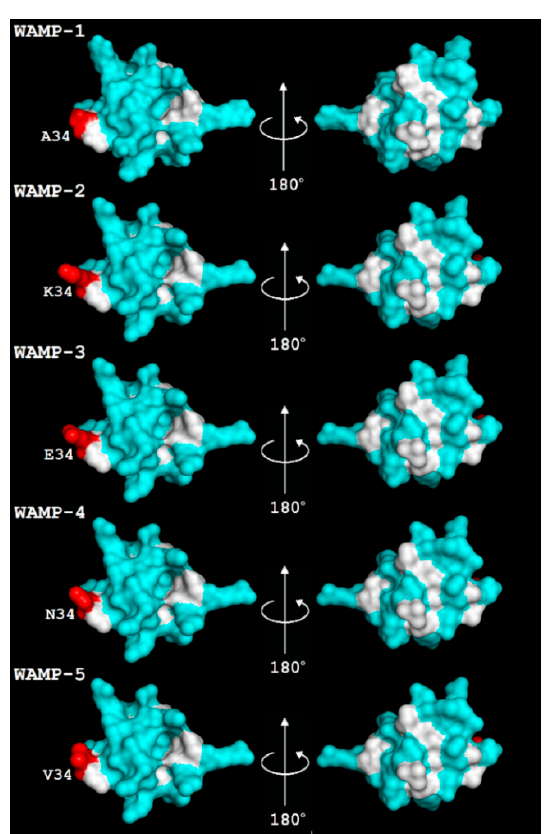
Figure 2. The spatial structure of WAMP-1a (PDB 2LB7) and 3D structure models of WAMP homologues. Modeling was carried out using SWISS-MODEL [37]. The residue at position 34 is shown in red. Non-polar residues are colored white, and polar residues are colored cyan.